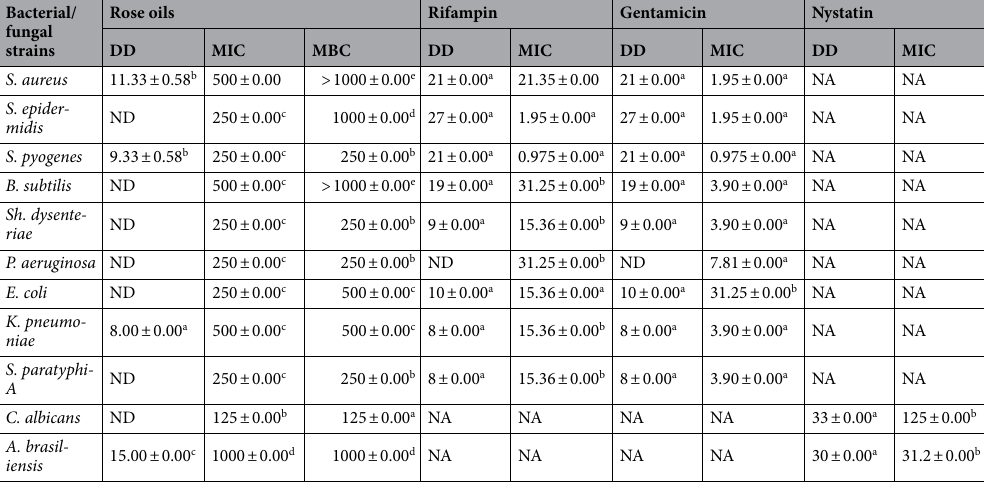
Table 2. Inhibition-zone diameters, Minimal inhibitory concentrations (MIC) and Minimal bactericidal/ fungicidal (MBC) concentrations of essential oil of R. damascena and referent antibiotics. DD the diameters of the inhibition zones includes the diameters of disks (6 mm), ND not determined, NA no activity; Values with different letters are statistically different (Duncan, p ≤